Question: In a single sentence, describe what this figure presents.
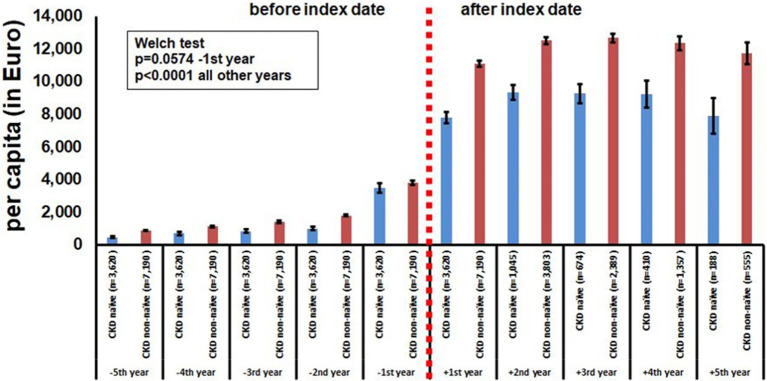
Answer: Average total healthcare costs (per capita in Euro) comparing CKD naïve and CKD non-naive arms over 5 years before and after the index date of the first dialysis. CKD naïve versus CKD non-naive: p < 0.0001 and p = 0.0574 (Welch’s t -test); Data are given with 95% confidence interval (CI). The number of patients at risk decreases progressively from the second year after the index date.